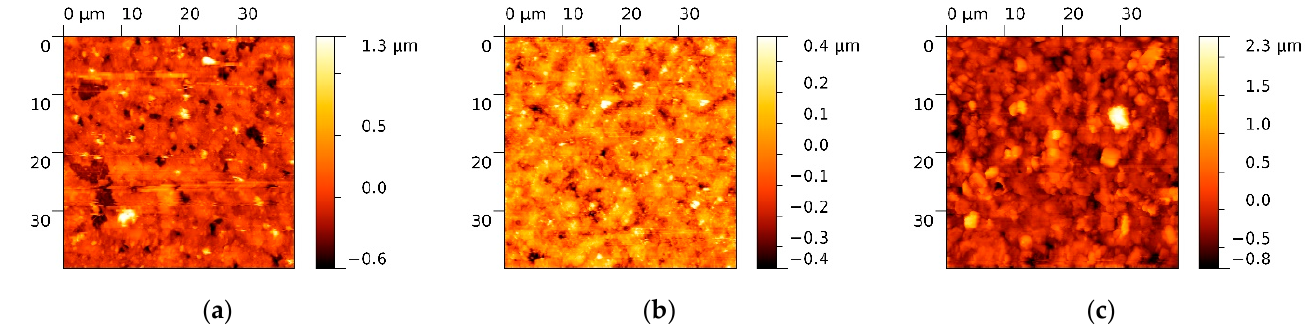
Figure 4. AFM images of ( a ) clean surface of the working electrode, ( b ) SnO 2 pixel transferred at 100 mJ/cm 2 laser fluence on the surface of the working electrode, and ( c ) Pd-SnO 2 pixel transferred at 100 mJ/cm 2 laser fluence on the surface of the working electrode.